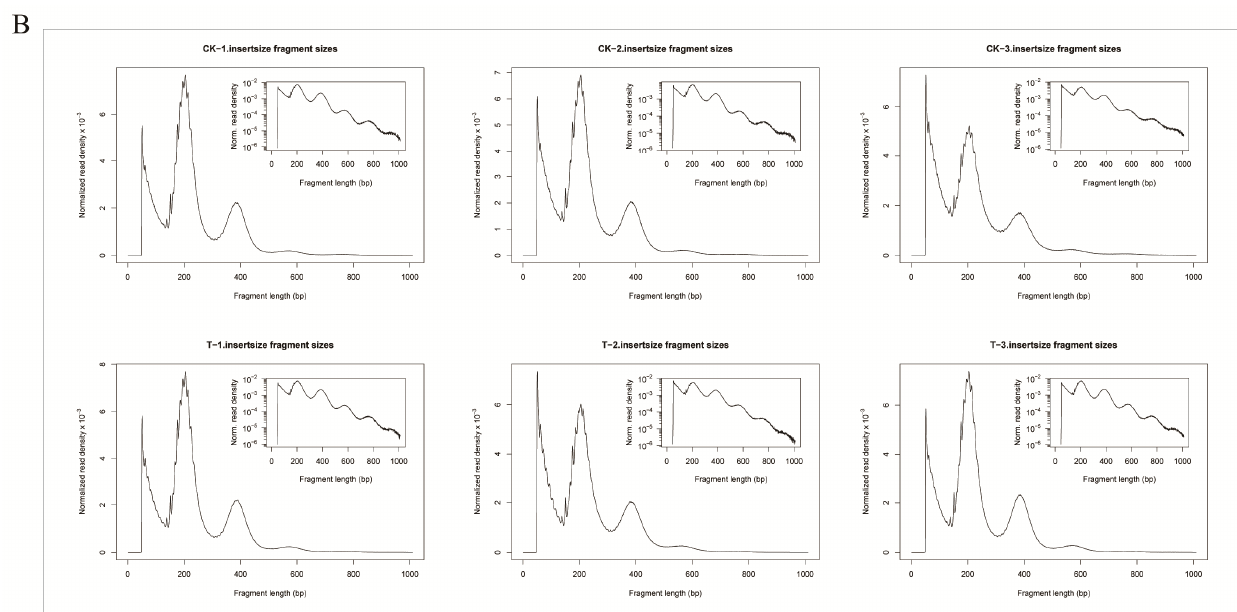
Figure 3. ATAC-seq quality control. ( A ) The top and bottom figures show the average read depth and enrichment of the ATAC − seq signals around the transcription start site (TSS), respectively. ( B ) Distribution of the fragment of each sample. The x axis represented the length of fragment, and the y axis represented the proportion of the fragment to all the fragments. The left − top was a nucleosome- free fragment corresponding to the open chromatin region (the nucleosome cleaved fragment <147), and the highest peak on the right corner was the open chromatin fragment representing the fragment including two nucleosomes (the nucleosome cleaved fragment >147 and <147 × 2) and another fragment including several nucleosomes, which is the characteristics of the open region of chromatin. Table 1. ATAC-seq data statistics.